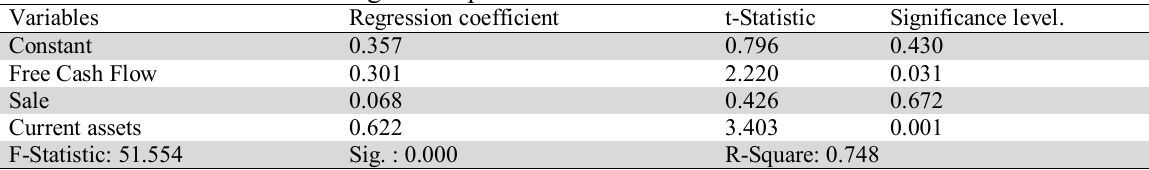
Estimates of combined linear regression